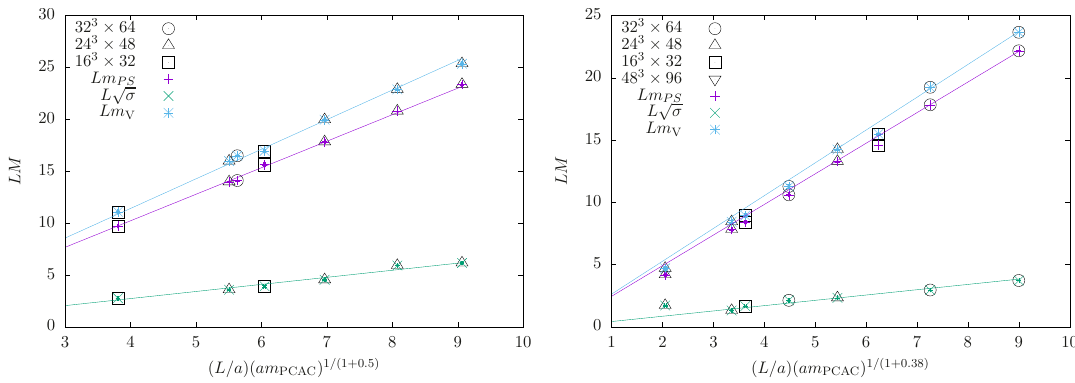
Figure 9 . A cross check of the scaling exponents obtained from the mode number with the scaling of the particle masses. These (cid:12)gures show a (cid:12)t to the hyperscaling hypothesis of the masses including volume scaling. The points with the smallest values on the x-axis correspond to the ensembles B ( (cid:12) = 1 : 5) and K ( (cid:12) = 1 : 7). The lines correspond to a linear (cid:12)t, in case of (cid:12) = 1 : 7 without the data of ensemble